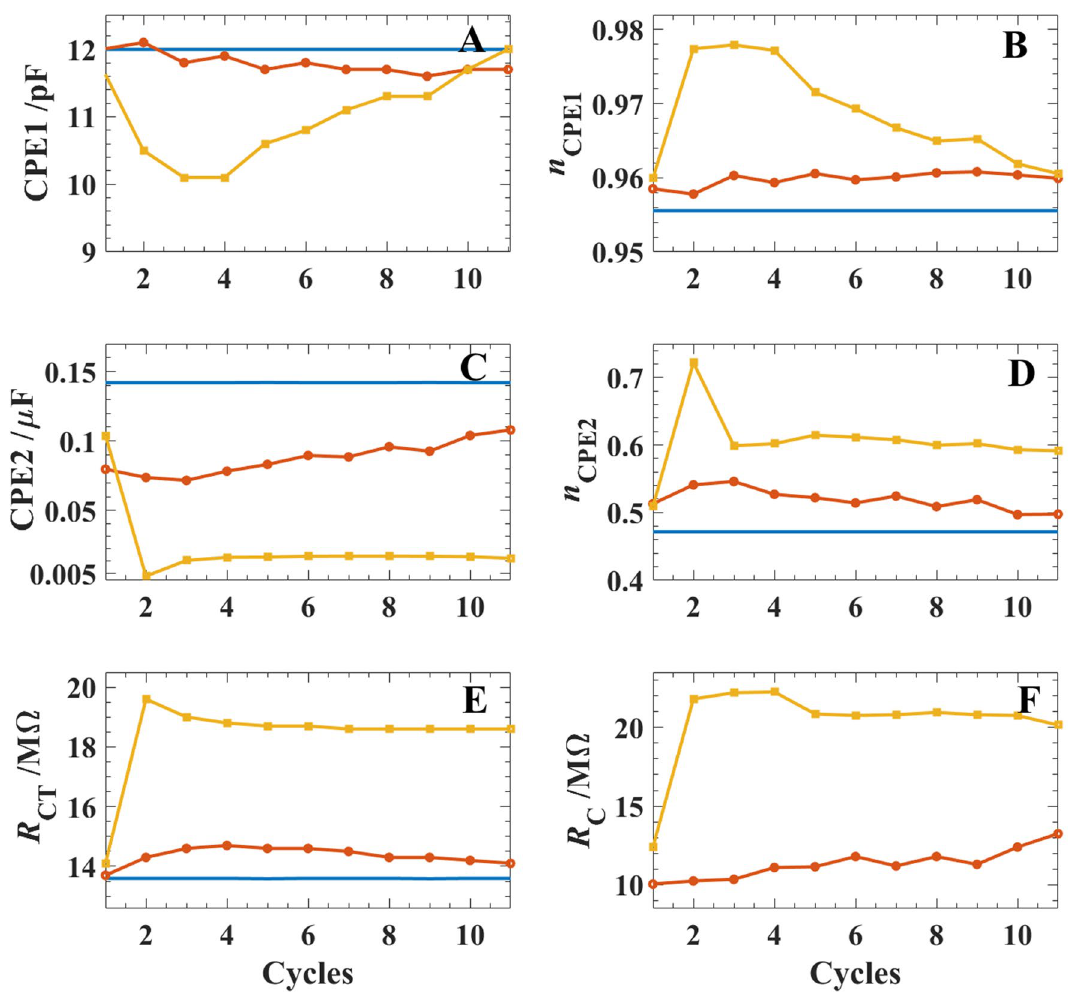
Figure 5. Equivalent electric circuit (EEC) parameter values obtained from fitting experimental impedance spectra from Fig. 4A–C using EEC2 depicted in Fig. 4D, with the orange filled circle and yellow filled square, curves derived from curve fitting impedance data obtained from Cell 1 with [TT] = 5 and 20 mM, respectively. The blue trace was determined using Cell 1 with [TT] = 0